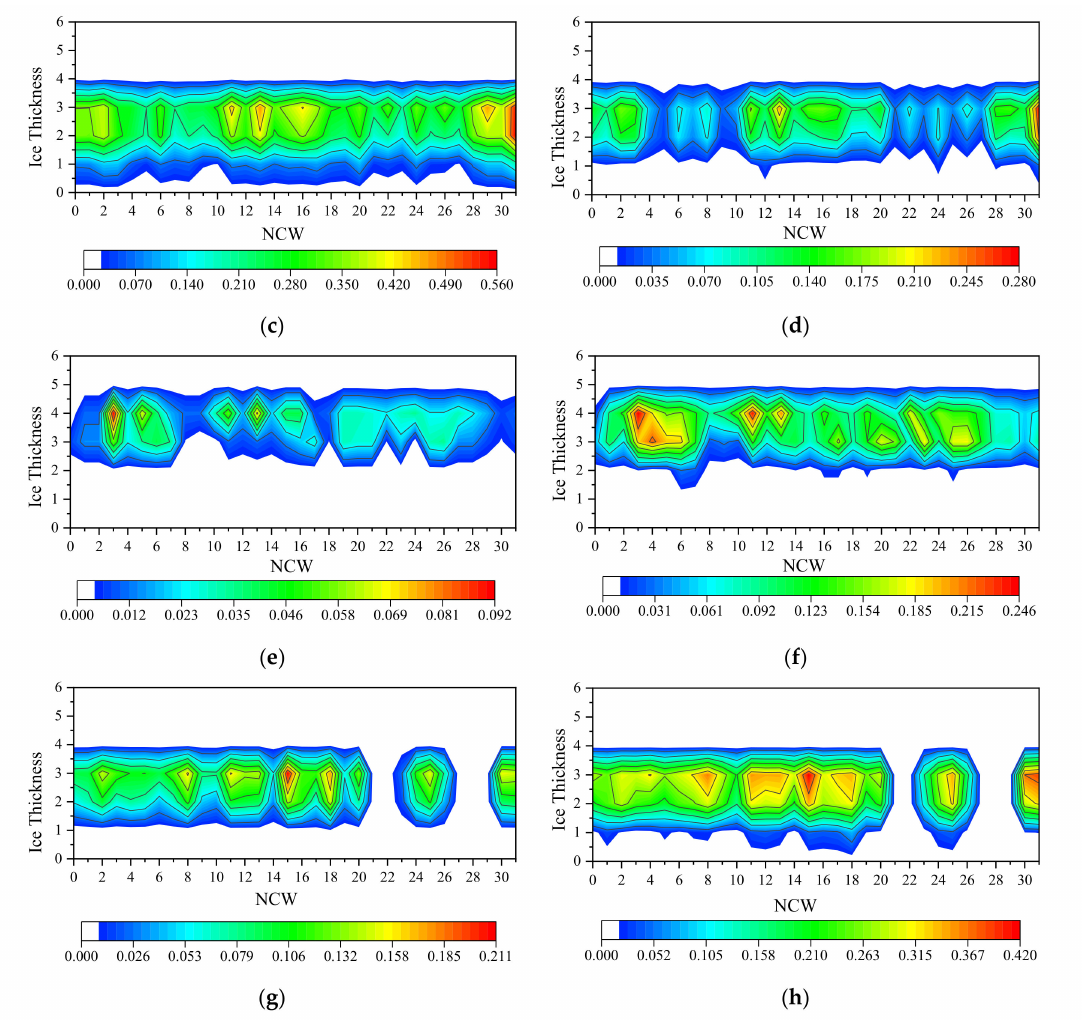
Figure 6. Probability contour maps of the LIP distribution area on the NCA at various